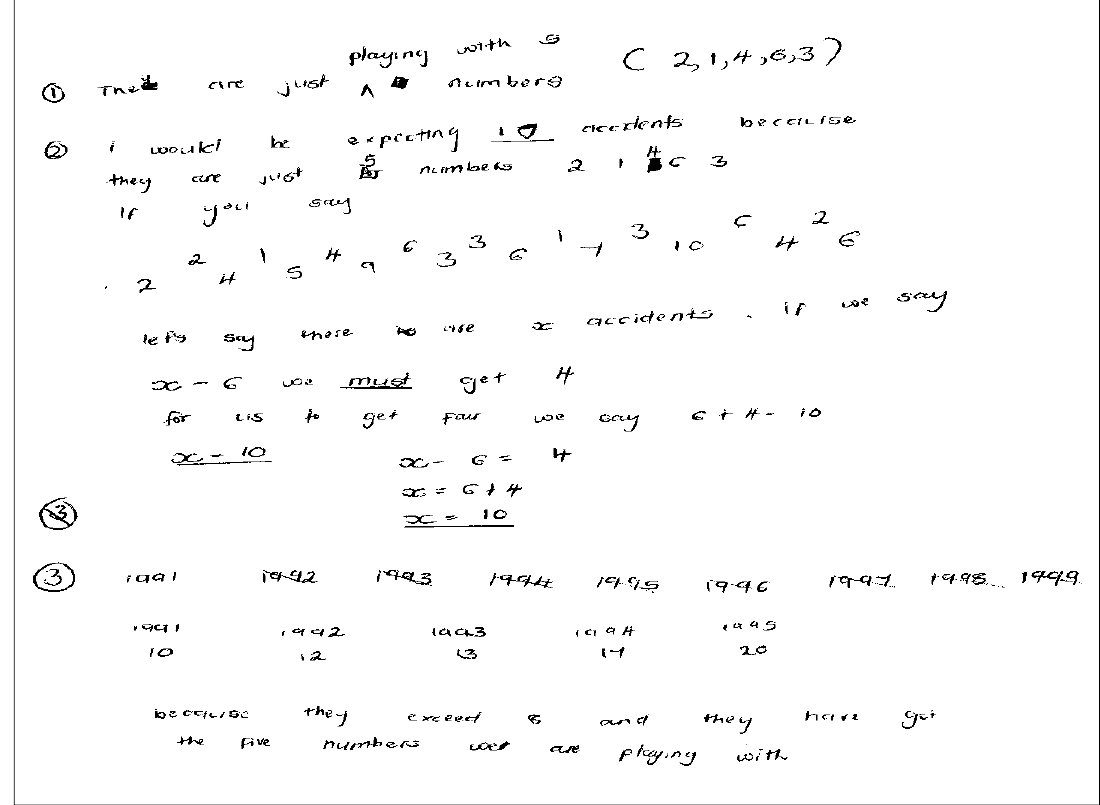
Figure 2 : Learner E’s written response to Task